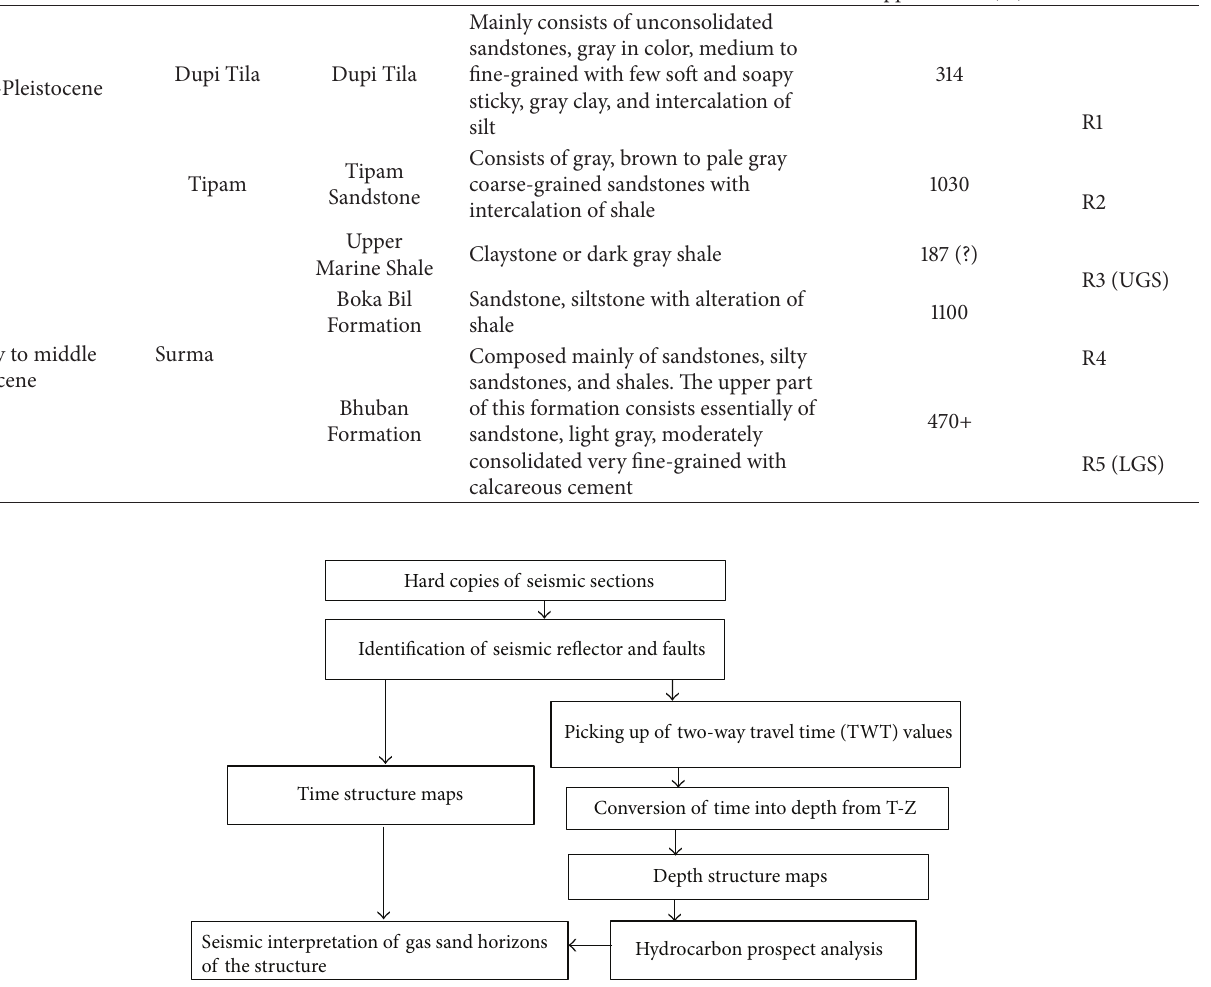
horizons and reflection times were picked up based on tracking the amplitude contrast boundary to prepare time structure maps. The T-Z curve was used for conversion to time (TWT) into depth to prepare depth structure